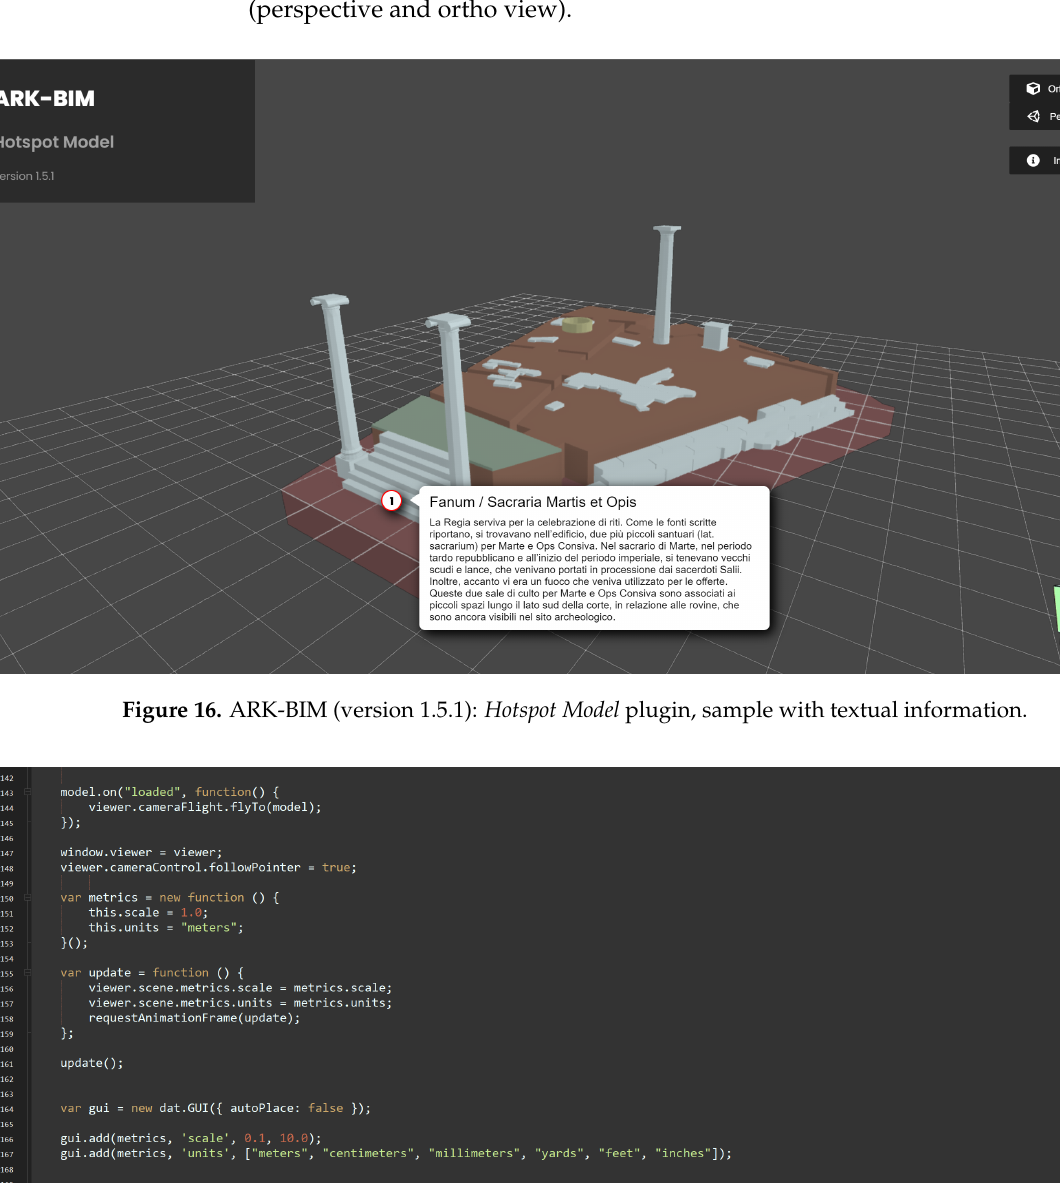
Figure 15. ARK-BIM (version 1.5.1): Hotspot Model plugin, sample with an image reference.